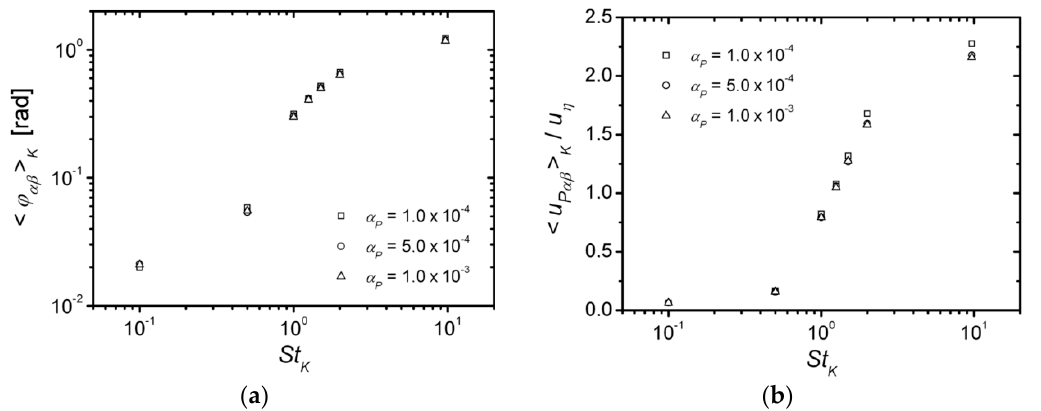
Figure 8. Average velocity collision angles ( a ) and relative velocities ( b ) for colliding particles as a function of particle Stokes number for the three evaluated average volume fractions.